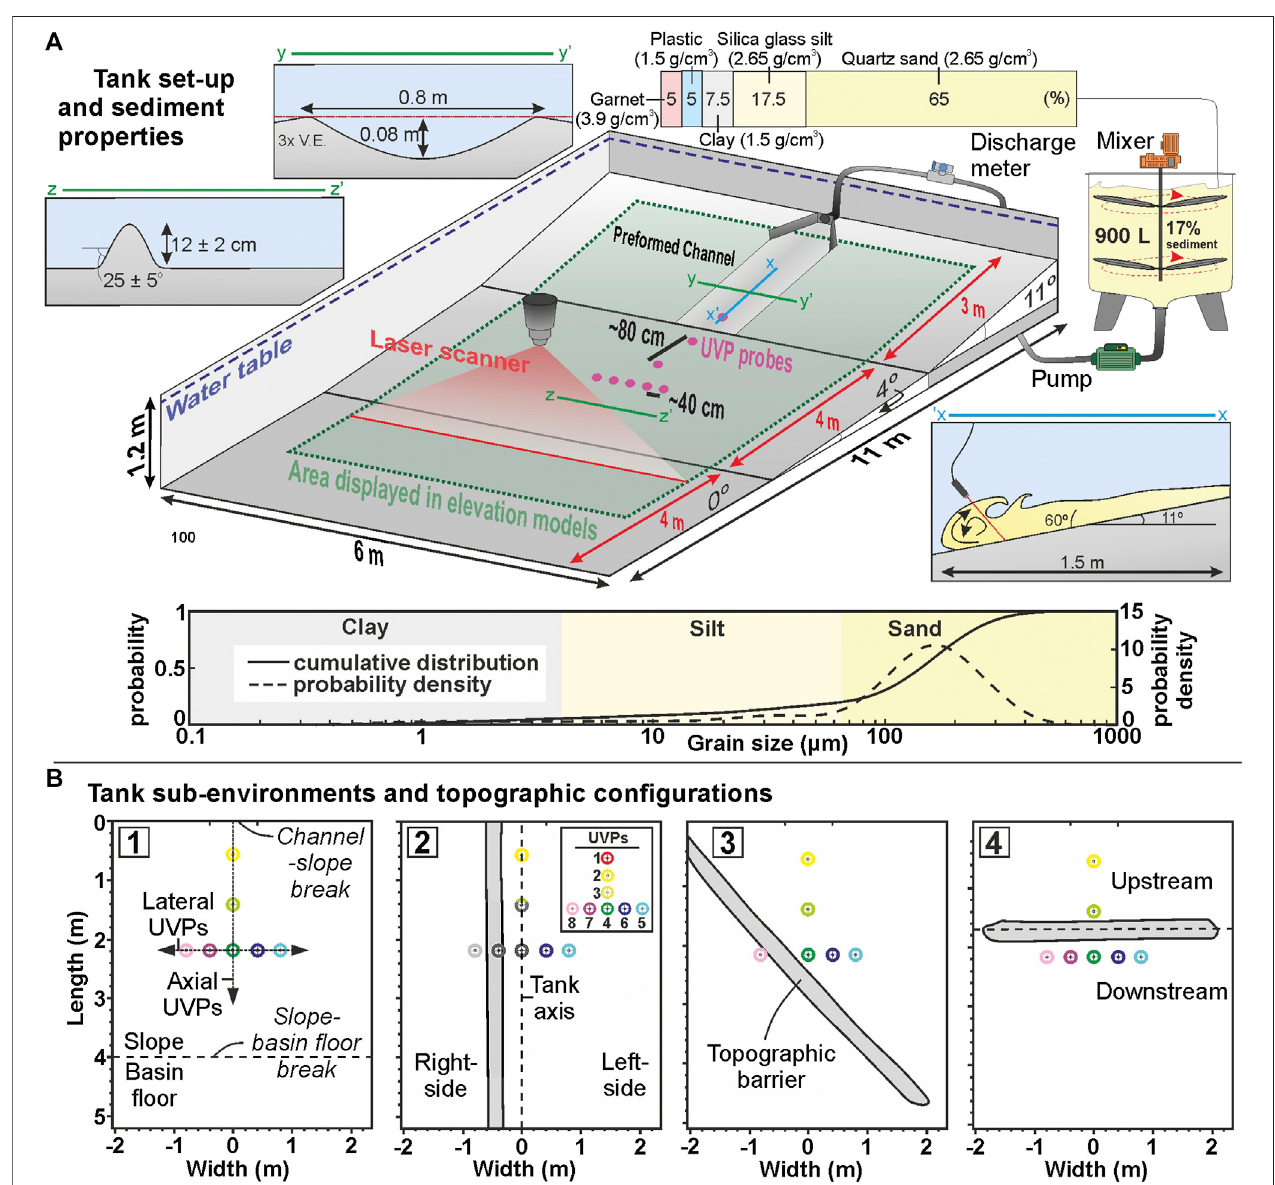
FIGURE1|(A) Keyfeaturesanddimensionsoftheexperimentalmethod showingthechannel,slope,topographyandsedimentmixture.UVPprobepositionsand sediment composition are also indicated (modi fi ed from Ferguson et al., 2020). Grain-size distributions are derived from Malvern Mastersizer analysis. (B) Tank sub-environments and topographic con fi gurations discussed in text. The left- and right-sides of the tank are with respect to the fl ow.